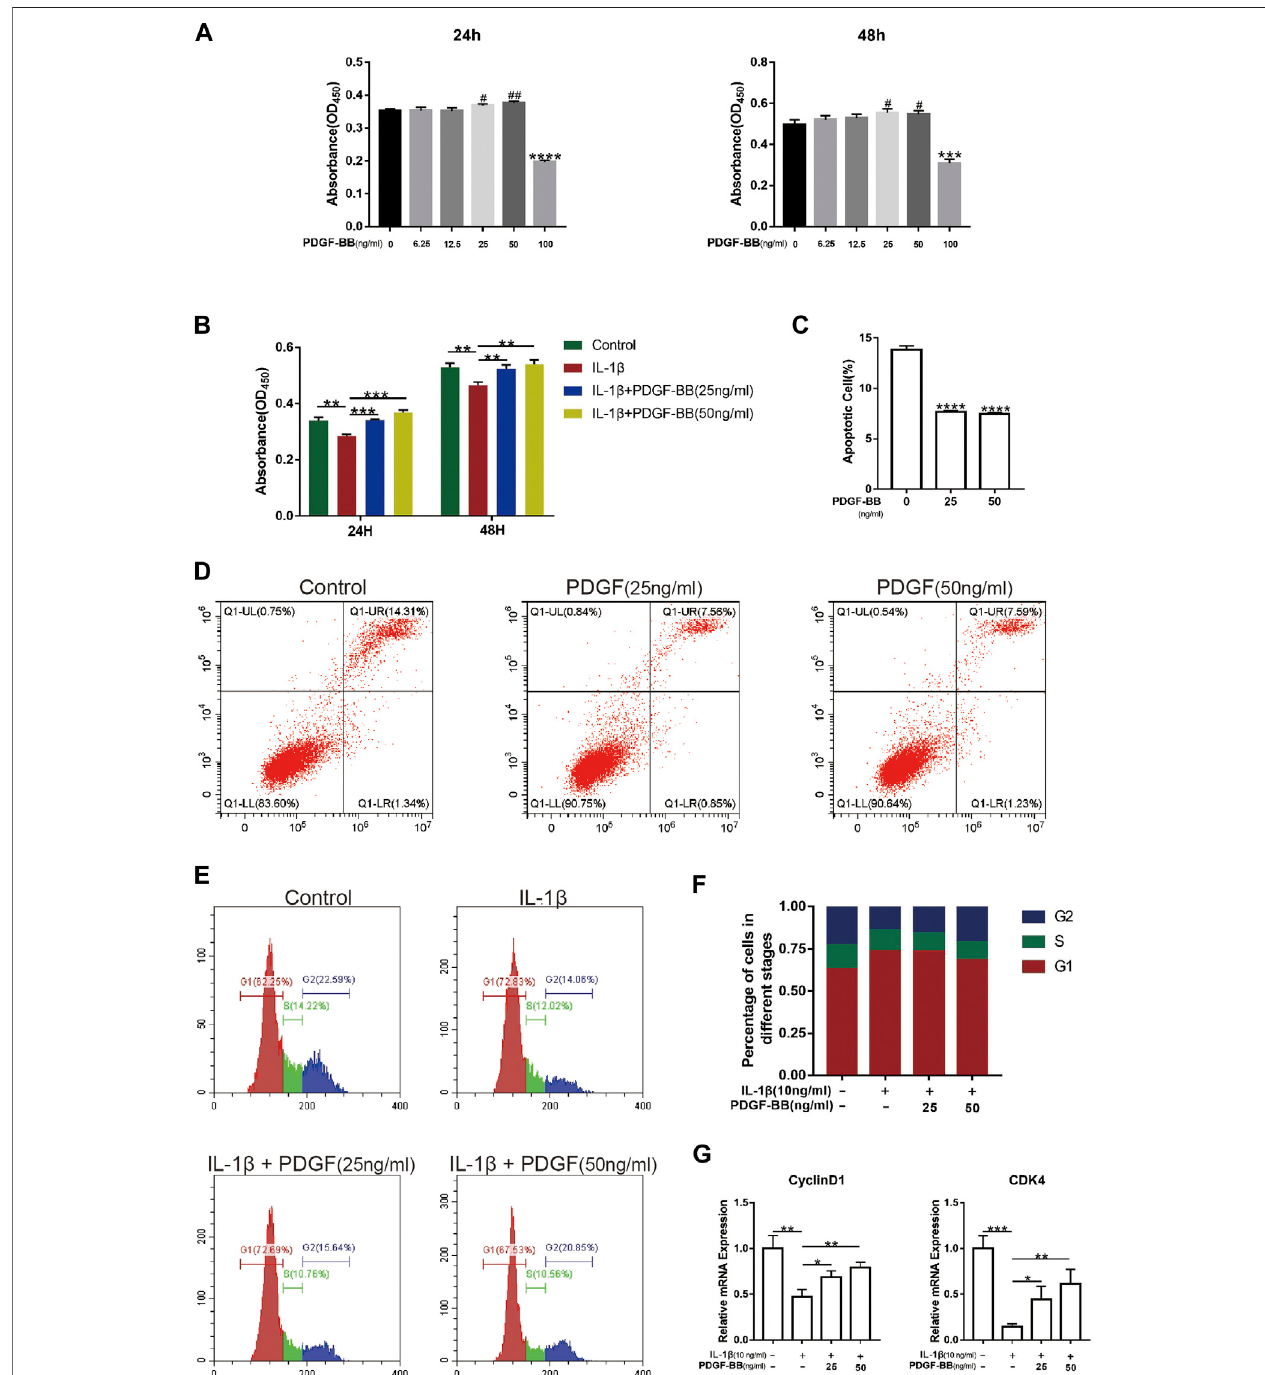
FIGURE 3 | PDGF-BB alleviates cell cycle arrest and apoptosis in NP cells. (A) The CCK-8 assay measured effects of the indicated concentrations of the recombinant PDGF-BBprotein onthetoxicityofNPcellsat 24and48 h. (B) TheCCK-8assaymeasured effectsofPDGF-BB andIL-1 β onthecytotoxicityofNPcellsat 24 and 48 h. The96-wellplates contained 2,000NPcells per well. (C,D) The apoptosis ofNPcells wasevaluated by fl owcytometry. (E,F) The cellcycle ofNP cellswas evaluated by fl ow cytometry. (G) The mRNA expression levels of CyclinD1 and CDK4 were measured by qPCR. The expression of these genes was normalized to the expression of GAPDH. Data are presented as the mean ± SD. Signi fi cant differences between groups are indicated as **** p < 0.0001, *** p < 0.001, ** p < 0.01, * p < 0.05.